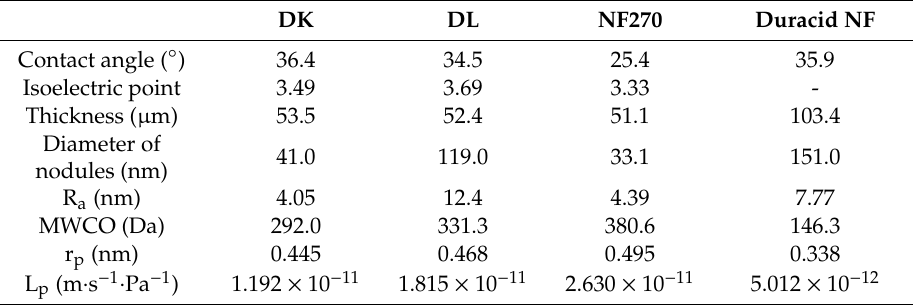
Table 4. Properties of four NF membranes active layer obtained in this study.